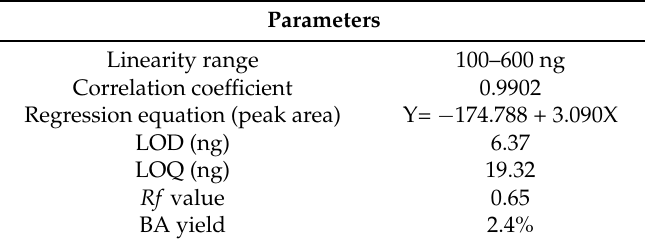
Figure 4. Normal distribution graph between residuals and normal score. Table 1. Densitometric validation summary of betulinic acid.